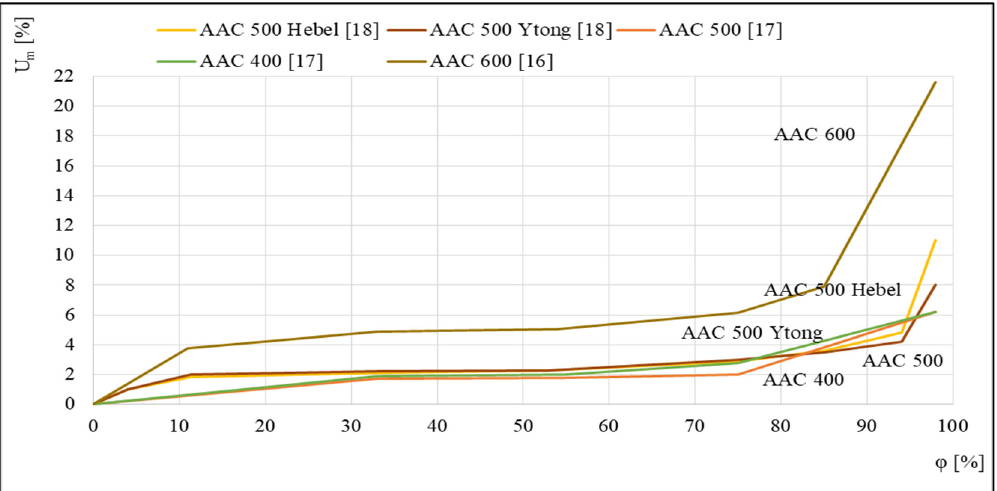
Figure 3. Sorption isotherms, based on [16–18].